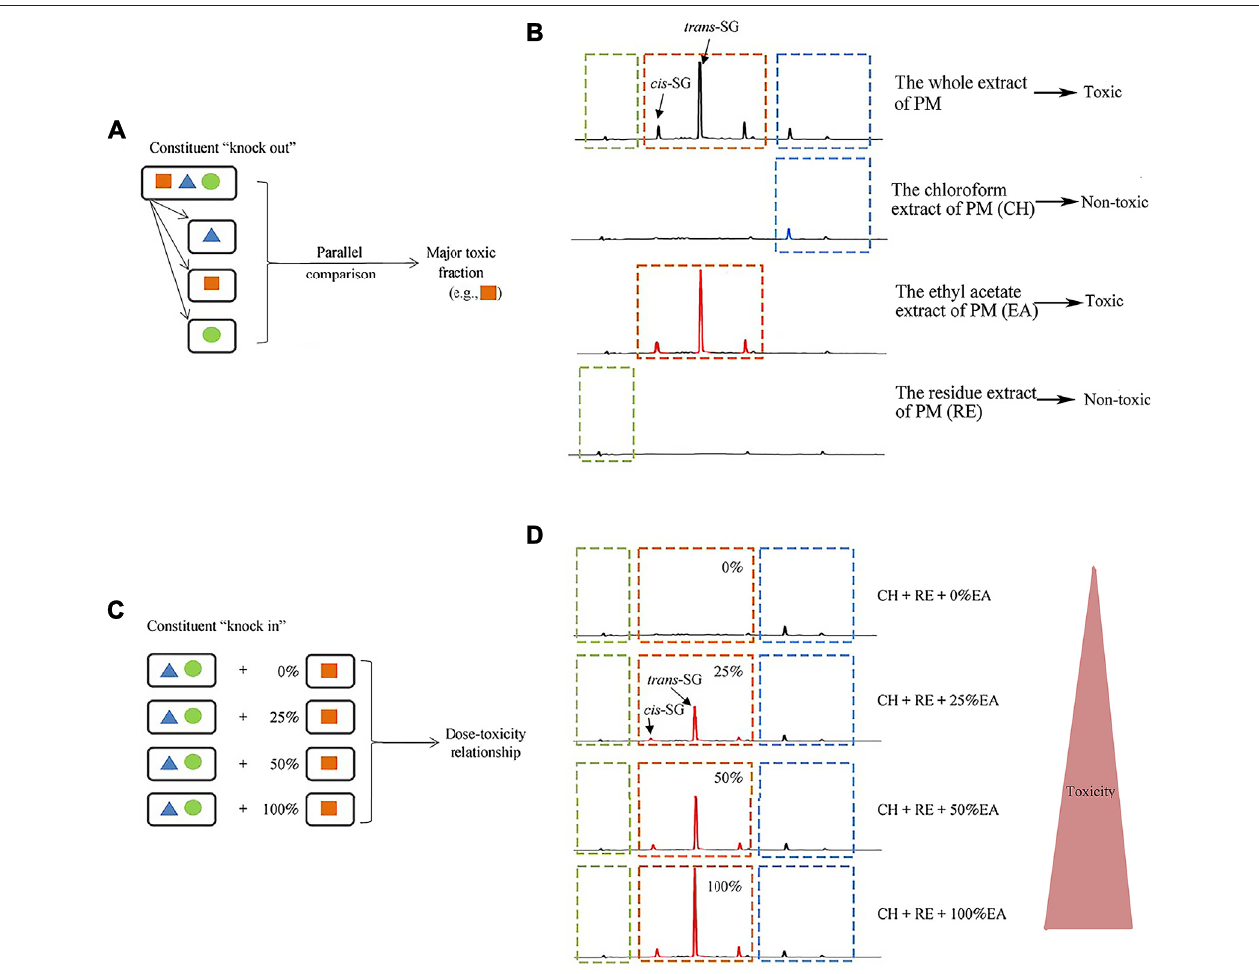
FIGURE1| Administration ofthe stilbene-containingethyl acetate extract ofPMto LPS-treated ratsresulted inhepatotoxicity.Adaptedfrom reference(LiC. et al., 2017), with permission from Springer, 2021. Abbreviations: trans -SG, trans -2,3,5,4 ’ -tetrahydroxystilbene-2-O- β - glucoside; cis -SG, cis -2,3,5,4 ’ -tetrahydroxystilbene- 2-O- β -glucoside; PM, Reynoutria multi fl ora (Thunb.) Moldenke; CH, the chloroform extract of PM; EA, the ethyl acetate extract of PM; RE, the residue extract of PM.